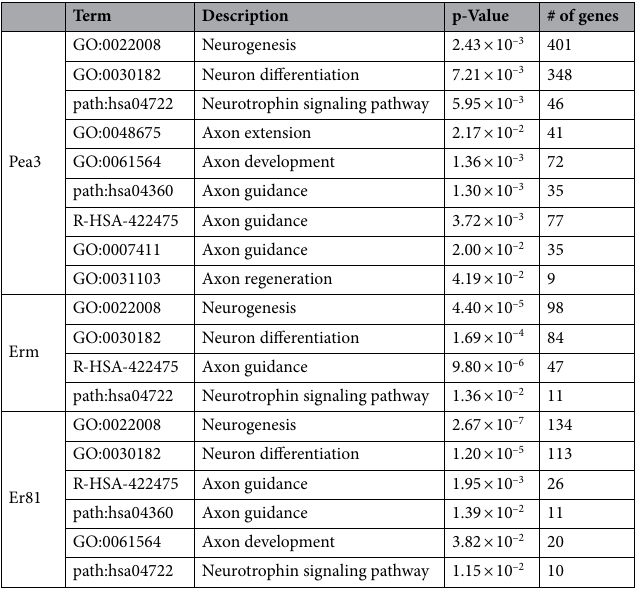
Table 2. Selected pathways related to neuronal development and function among enriched pathways in Pea3-, Erm- and Er81-transfected mHypoA-2/12 cells. GO Gene ontology, R-HAS Reactome, path:has KEGG term.